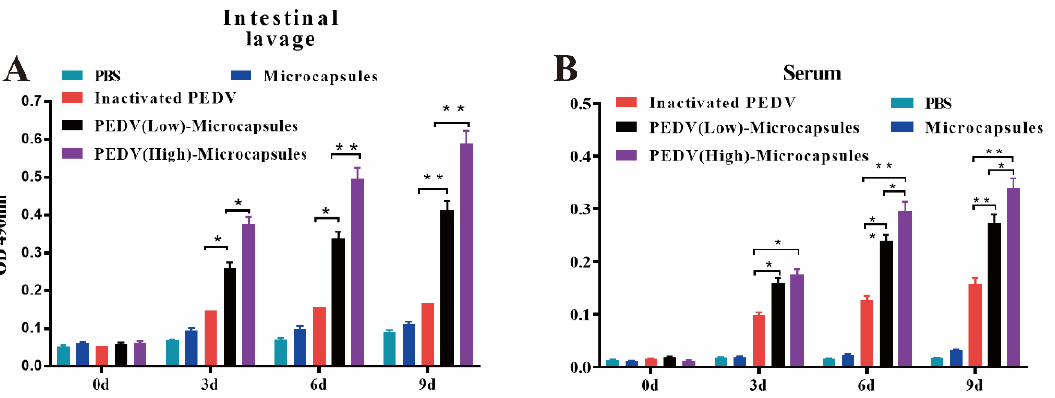
Figure 2. Enzyme-linked immunosorbent assay measures of antibodies IgA and IgG in feces ( A ) and serum ( B ) after the final immunity. The differences between means were considered significant at * p < 0.05 and very significant at ** p < 0.01.